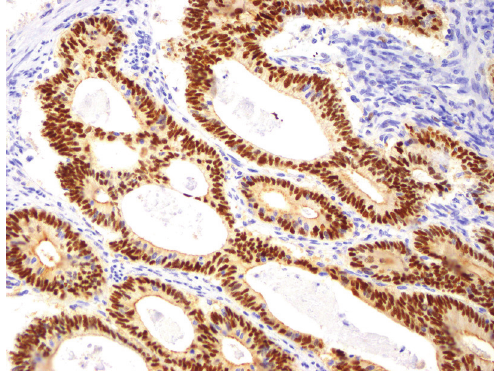
Figure 3: Representative example of immunopositivity grade 3 for cyclin E (original magnification × 200).